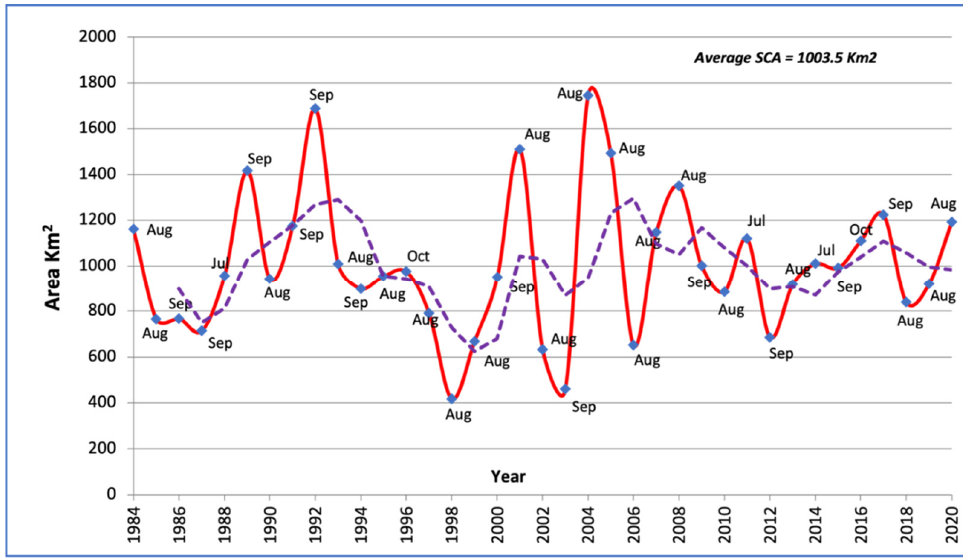
Figure 7. Time series of the maximum value of SCA in each year of the study period (solid line). The month of the maximum value has been labelled. The dashed line represents the 3-year running mean.